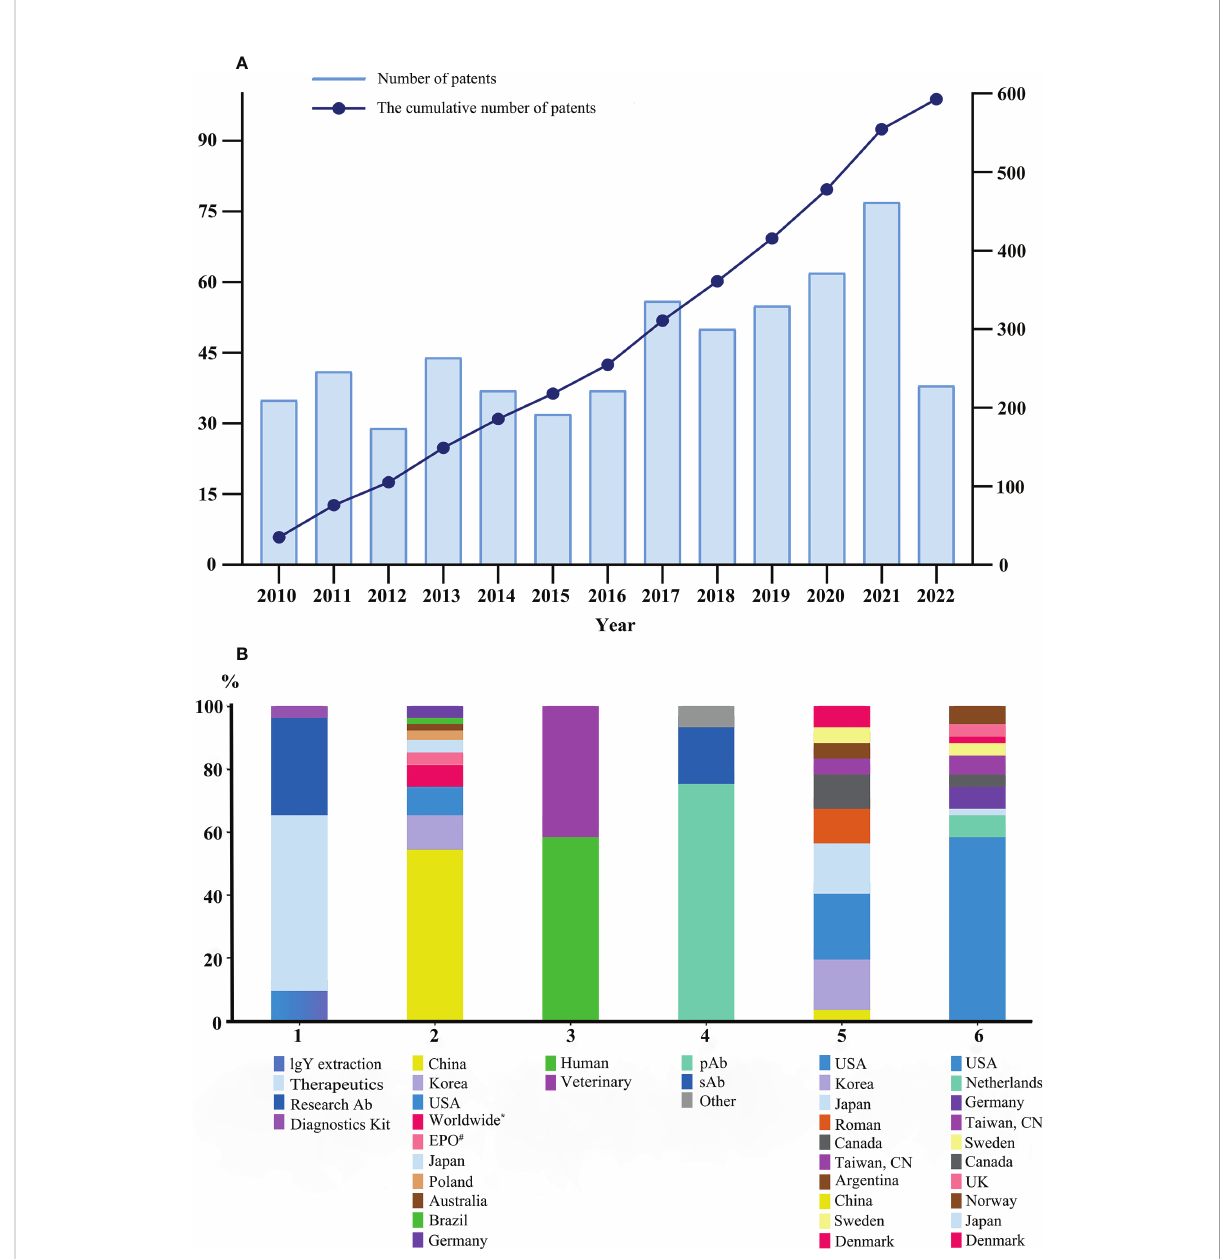
FIGURE 2 Status of IgY commercialization. (A) Trends in IgY patent applications, data from 2010 to June 2022. (B) 1: Distribution and purposes of patents applied worldwide. (B) 2: Geographic origins of patents related to IgY technology. Data from 2010 to June 2022. (B) 3: Distribution of biotherapeutics IgY product types. (B) 4: Distribution of diagnostic IgY (pAb: primary antibody; sAb: secondary antibody; other products: monoclonal antibody; tag antibody; and diagnostic kit). (B) 5 and 6: Top 10 countries for biotherapeutics and diagnostic IgY companies in the market, respectively. * Patent cooperation treaty system. # European Patent Of fi ce. Additional data on IgY commercialization in China were searched in the Chinese databanks and are summarized in Supplementary Table